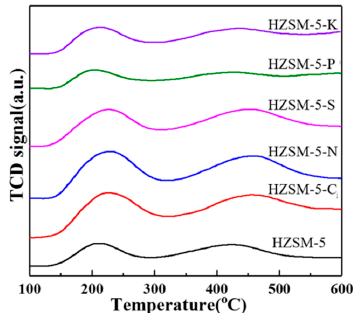
Figure 4. NH 3 -TPD images of synthesized HZSM-5 zeolites. Table 3. Distribution of acid sites and SiO 2 /Al 2 O 3 ratio of the catalyst.